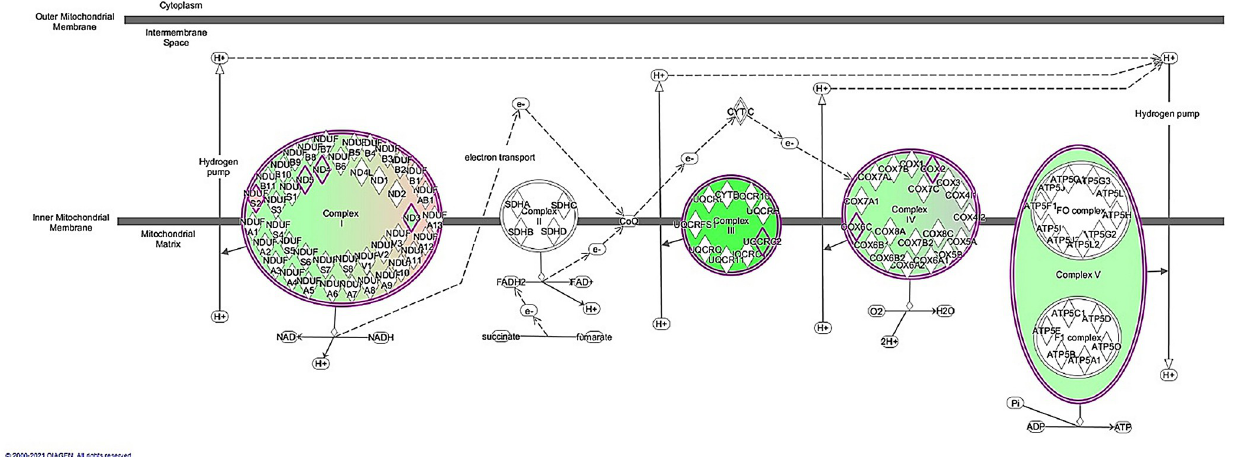
Fig 2. Oxidative phosphorylation pathway with genes predicted to be activated in pure Iberian (IBxIB; coloured in green) males when compared with Iberian x Large White crossbreds (IBxLW; coloured in red), obtained using Ingenuity Pathway Software (IPA).